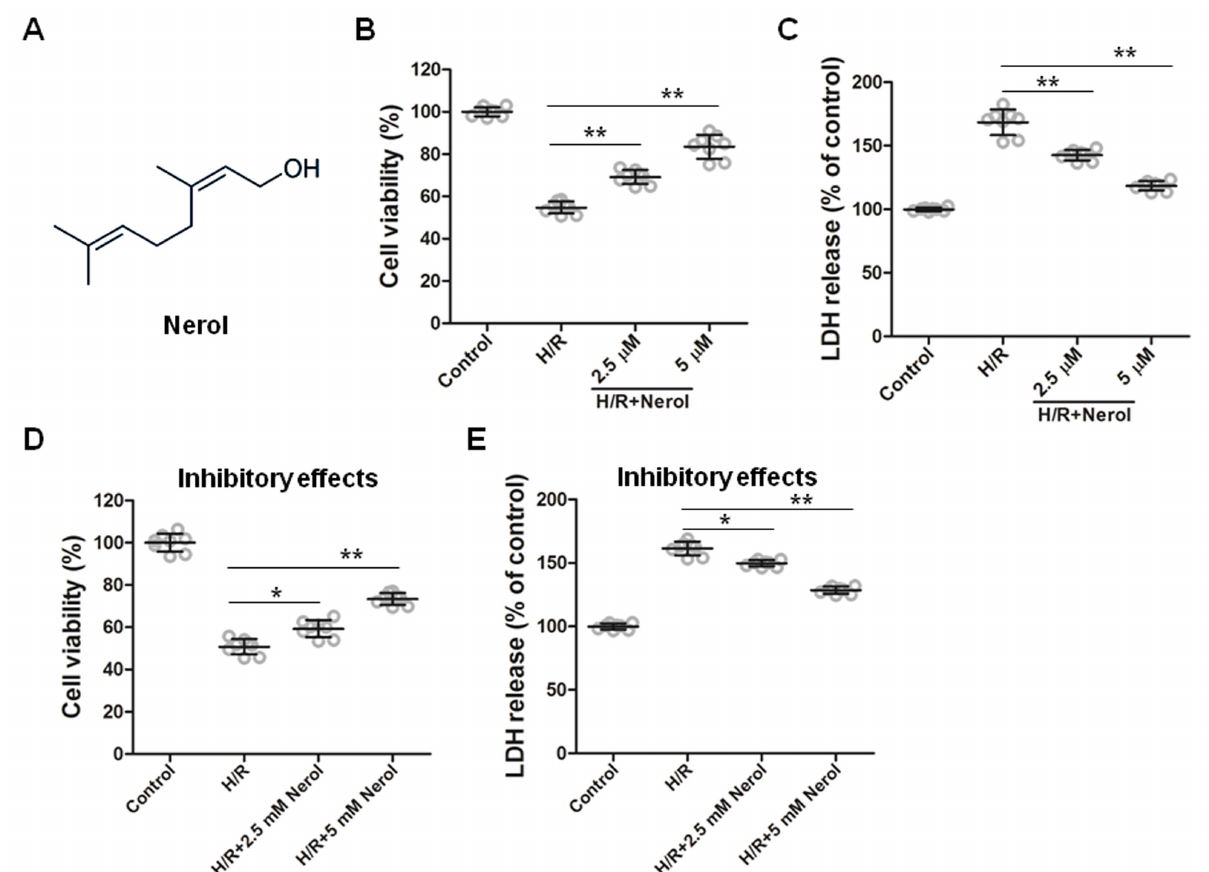
Figure 1. Nerol alleviated H/R-induced injuries in cardiomyocytes. (A) Chemical structure of Nerol. (B) H9c2 cardiomyocytes were treated with 2.5 μM or 5 μM Nerol, followed by H/R treatment for 12/12 h, followed by CCK-8 assay. (C) H9c2 cardiomyocytes were treated with 2.5 μM or 5 μM Nerol, followed by H/R treatment for 12/12 h, followed by LDH release assay. (D) H9c2 cardiomyocytes were pre-treated with H/ R treatment for 12 h, followed by 2.5 μM or 5 μM Nerol for 12 h, followed by CCK-8 assay. E. H9c2 cardiomyocytes were pre-treated with H/R treatment for 12 h, followed by 2.5 μM or 5 μM Nerol for 12 h, followed by LDH release assay. n=8. p<0.05 (*), p<0.01